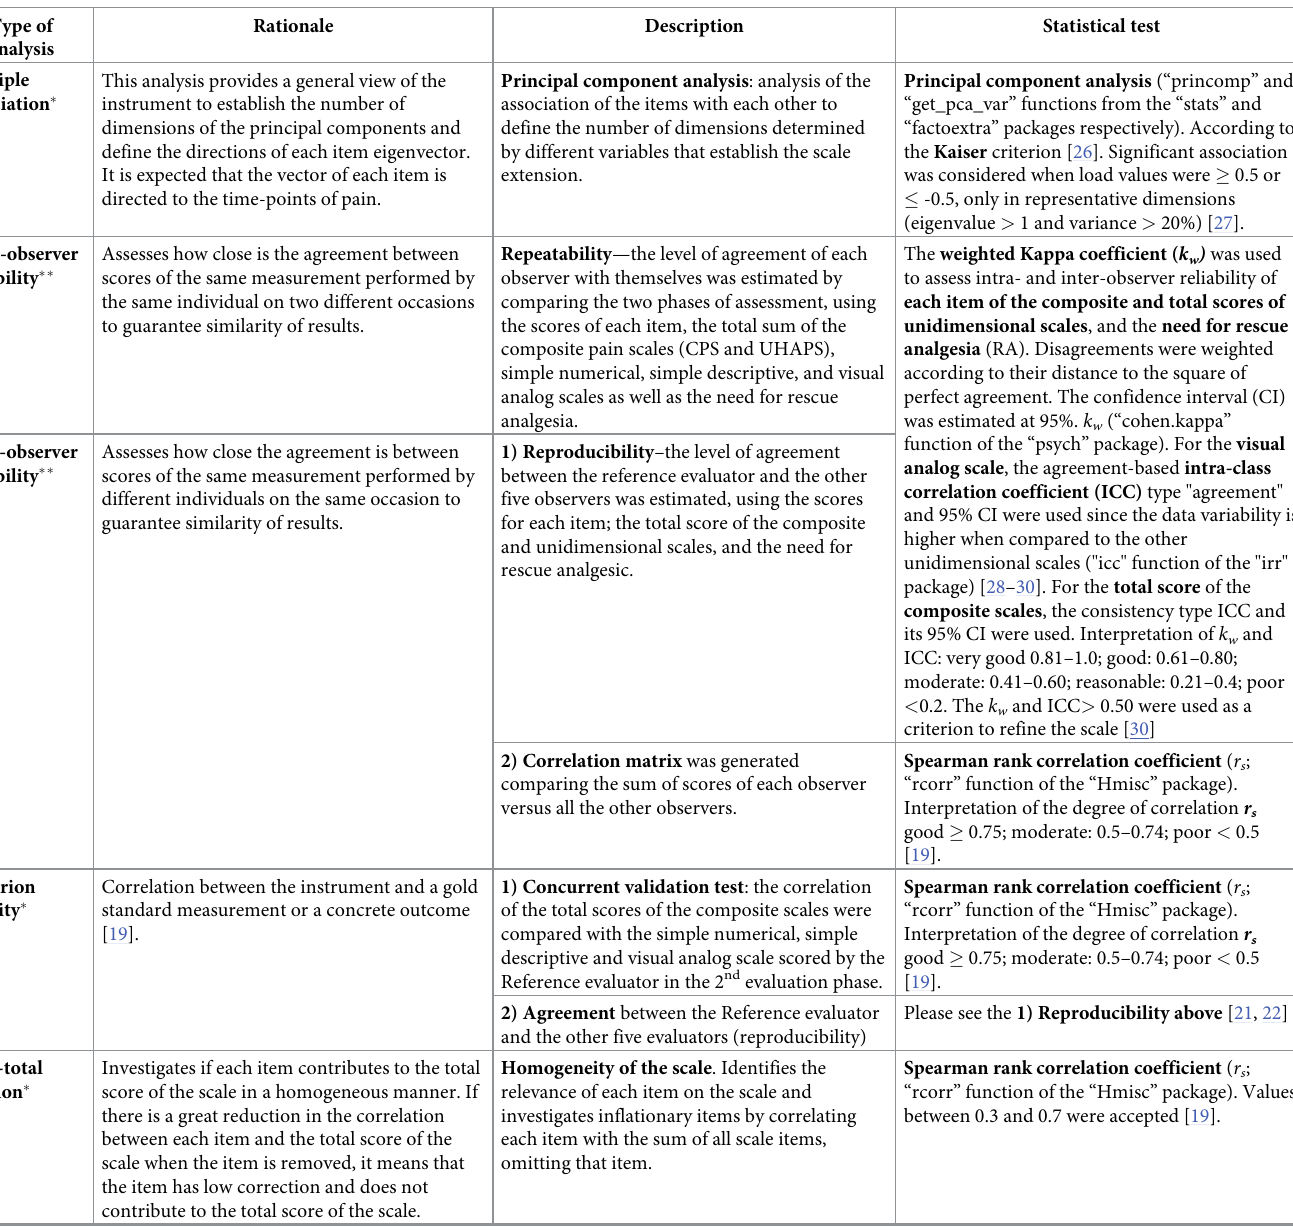
Table 1. Methods for statistical validation of the Unesp-Botucatu horse acute pain scale (UHAPS), Composite Pain Scale (CPS), and unidimensional scales to assess postoperative pain in